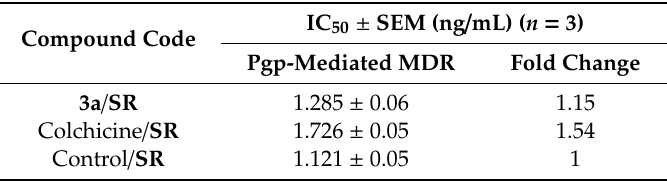
Table 6. In vitro growth inhibitory e ff ects of 3a in comparison to colchicine on multidrug-resistant leukemia cell line (MDR cells). Pgp—P-glycoprotein.